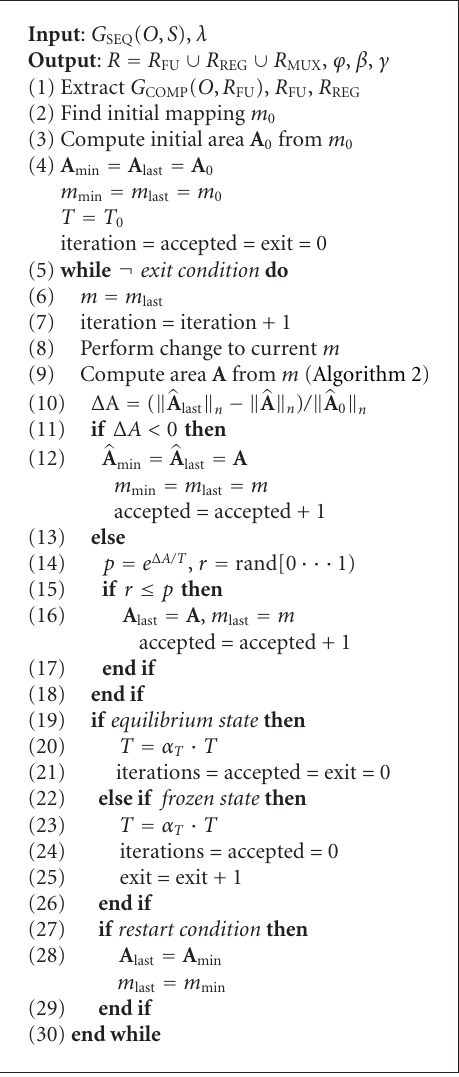
Algorithm 1: Optimization